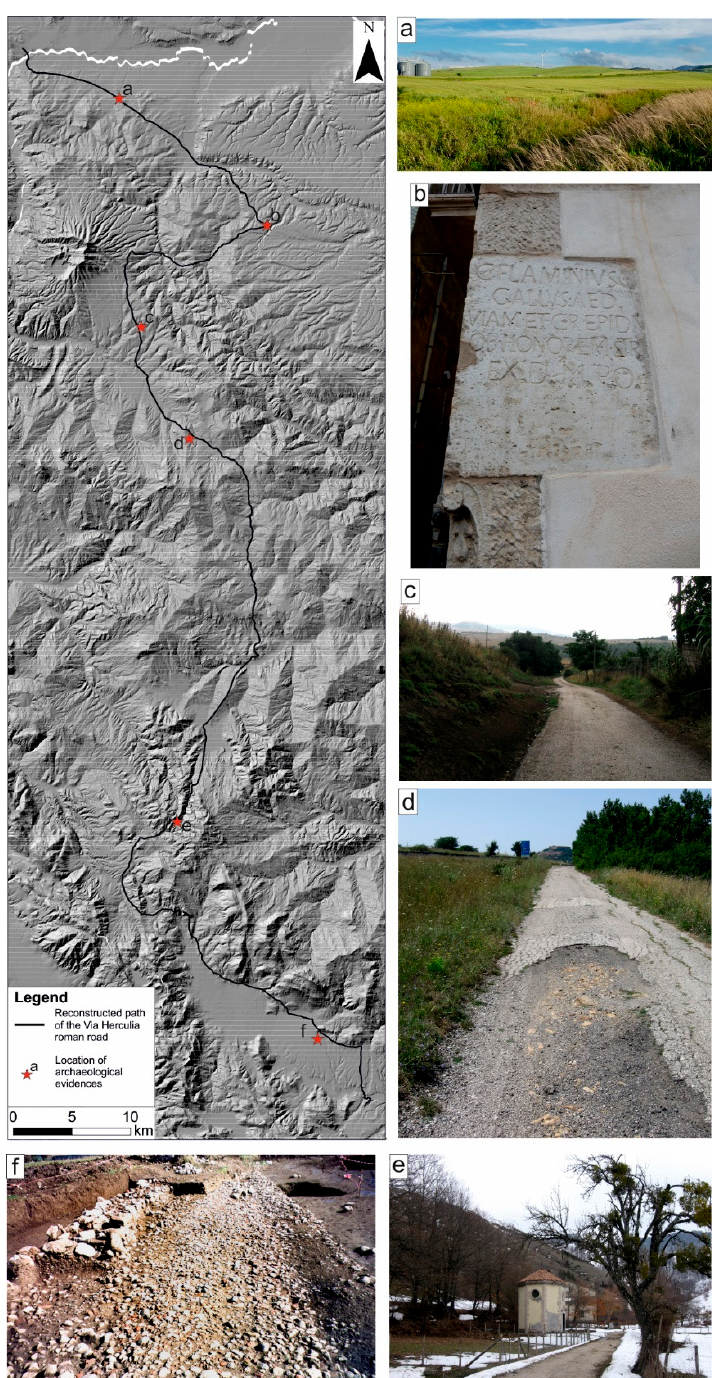
Figure 2. ( a ) The Herculia at the ford of Vallone di Catapane (XII milestone from Venosa), near the stop-over of Beleianum (villa in Serra dei Canonici; Melfi, PZ). ( b ) The remaking of an important road of ager Venusinus in the Flaminius Gallus onorary epigraph ( CIL , IX, 442; Venosa, PZ). ( c ) The Herculia in the Braida pass, one milestone before the stop-over of Pisandes (villa of Torre degli Embrici) and 23 miles from the Ofanto’s ford. The cobblestones are visible under the asphalt on its left side. ( d ) The road coming from Castel Lagopesole (Avigliano, PZ), VIII milestone from Pisandes near the stop-overs of ad fluvium Bradanum (and then Lucos ). ( e ) The road in the pass of Monte Arioso near the S. Michele church (Sasso di Castalda, PZ), XIII milestone from Potentia (Potenza). ( f ) Probably the road near the villa of Porcili, 10 miles from the stop-over of Acidios , now Fonte S. Giovanni near Marsico Nuovo